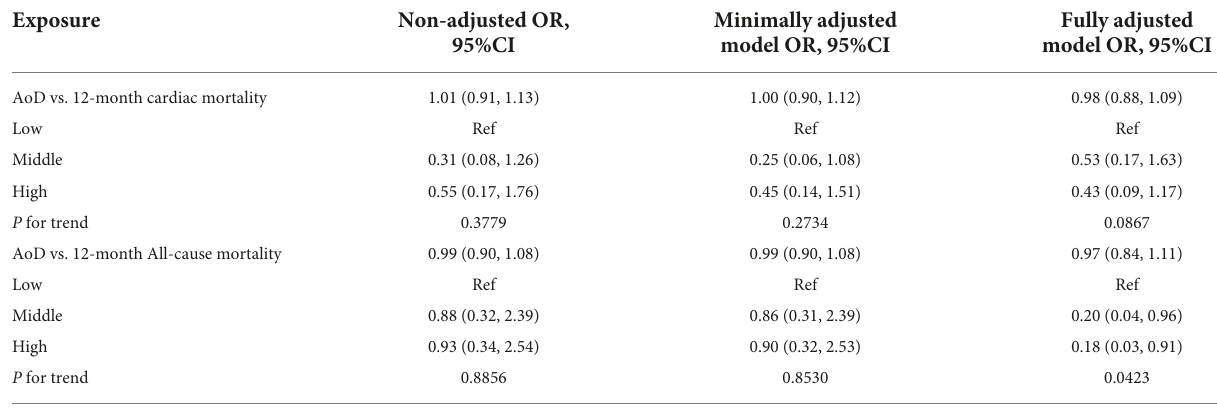
TABLE 2 The results of univariate and multivariate analyses using binary logistic regression